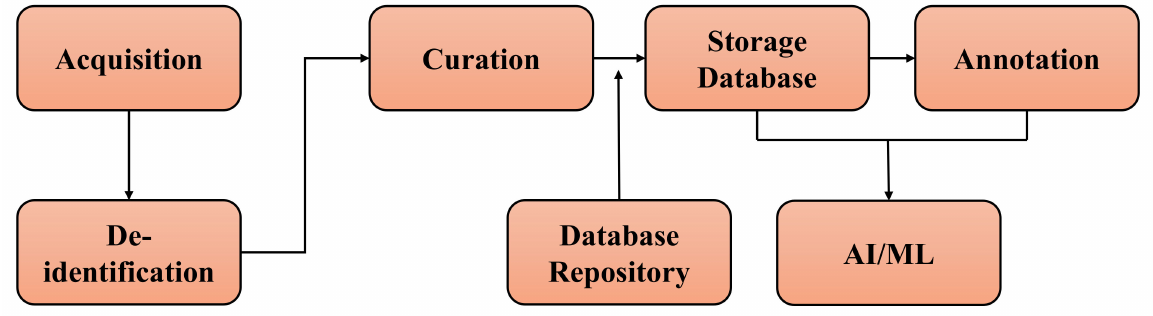
Figure 8. Data preparation pipeline for Supervised Machine Learning